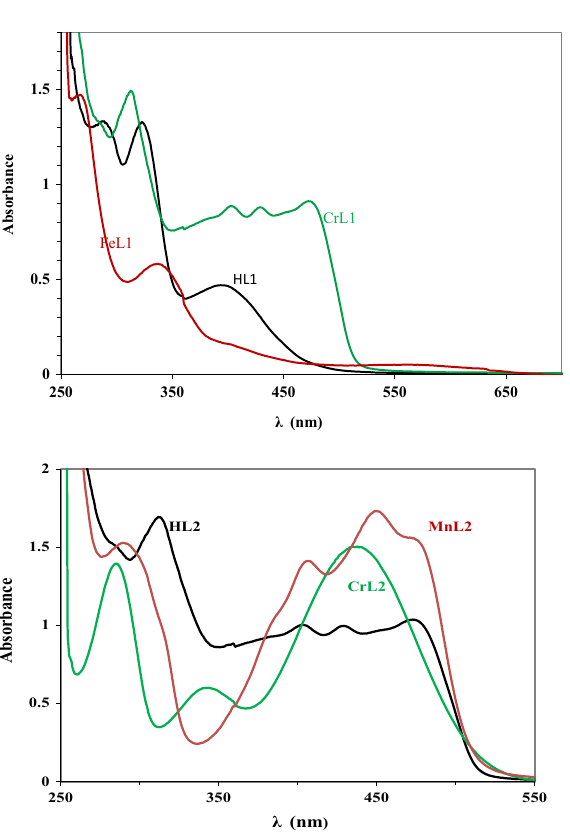
Figure 2. UV–vis spectra of the two ligands and their complexes with the metals CrL1, FeL1, CrL2, and MnL2 at concentrations of 10 −3 M in DMF at